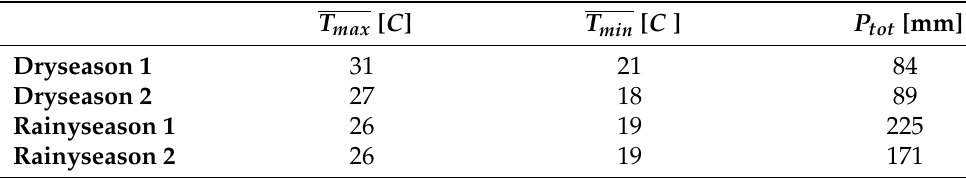
(cid:126) a curve in the same soil for dry and rainy periods. Figure 11. The σ a × The σ a values were treated and organized into four distinct periods, as follows: (i) Dry- season 1 period with higher temperature and therefore greater drought, (ii) Rainyseason 1 period with the highest precipitation indicator and therefore rainier, (iii) Dryseason 2 period with average temperature, beginning of the dry period and (iv) Rainyseason 2 period with average rainfall indicator, beginning of rainy season. Figure 11 shows σ a values for the periods mapped in the measurement interval and Table 1 provides the average temperature data of the highs T max , average temperature of the lows T min and total precipitation P tot in the four periods, from which data were taken from Meteoblue site of the University of Basel [31]. Table 1. Temperature and precipitation data for dry and rainy